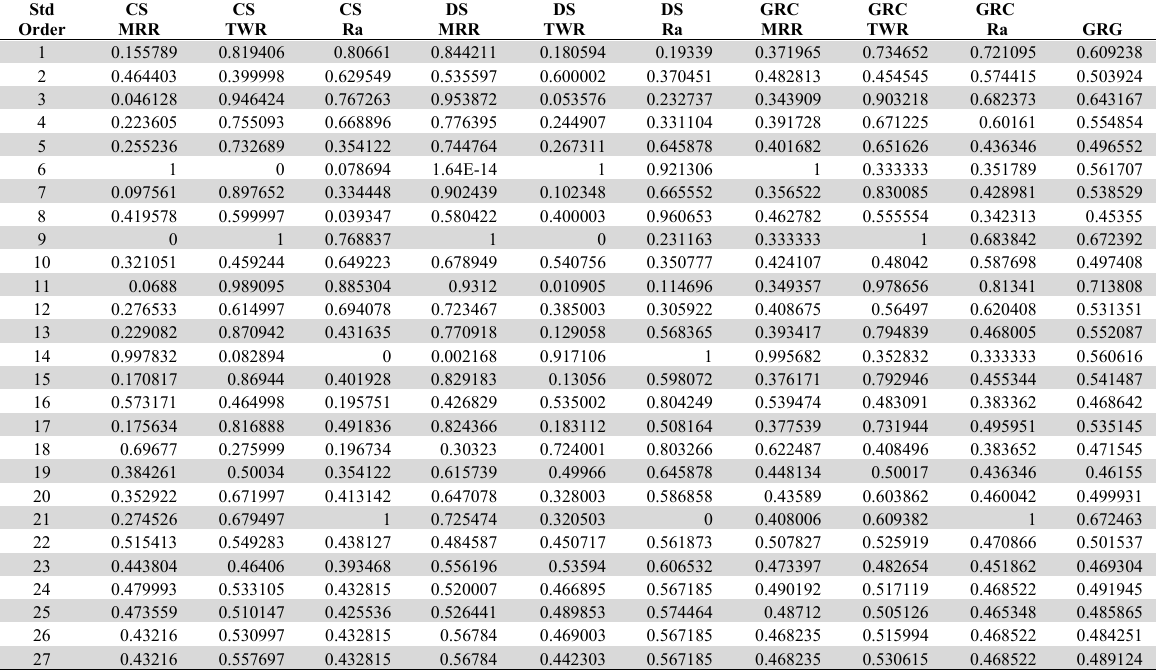
Experimental values, GRC and GRG of A356/WC